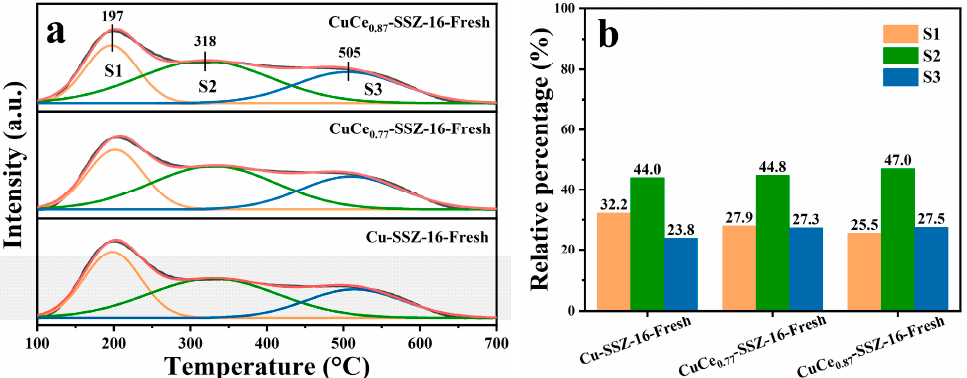
Figure 7. ( a ) Deconvolution of the NH 3 -TPD curves and ( b ) the corresponding areas over Cu-SSZ-16-Fresh, CuCe 0.77 -SSZ-16-Fresh, and CuCe 0.87 -SSZ-16-Fresh.